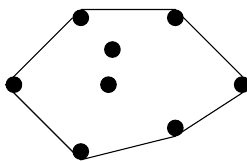
Figure 2: Simple example of a 2D convex hull of 8